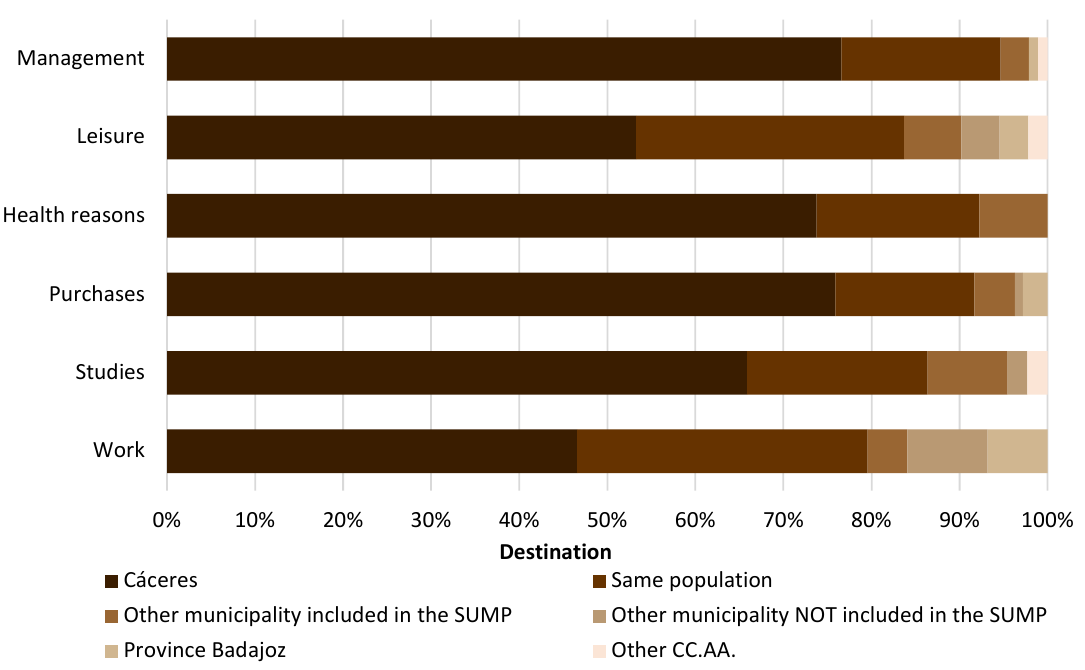
Figure 10. Destination of journeys of municipalities with a population between 500 and 2000 inhab- itants according to reason.